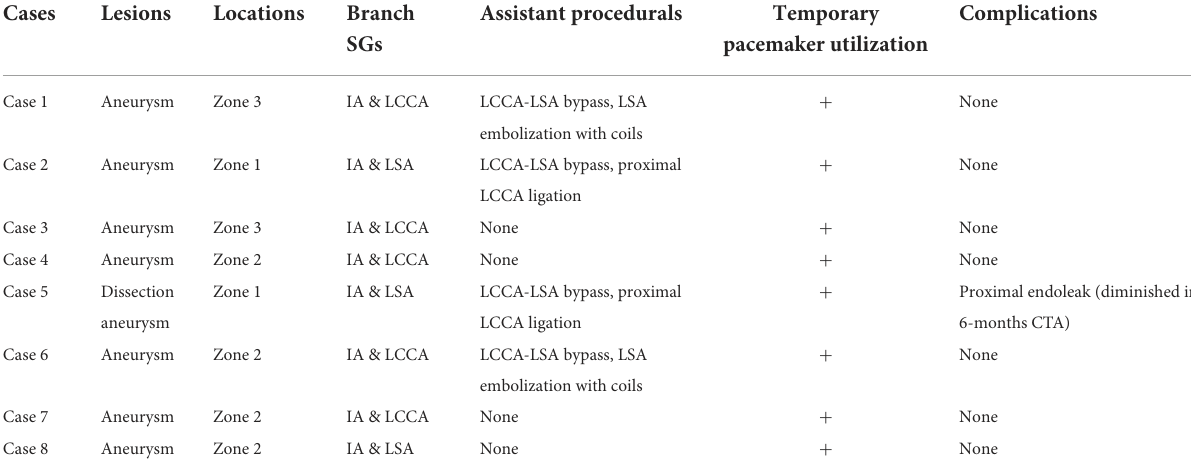
TABLE 1 Details of the eight